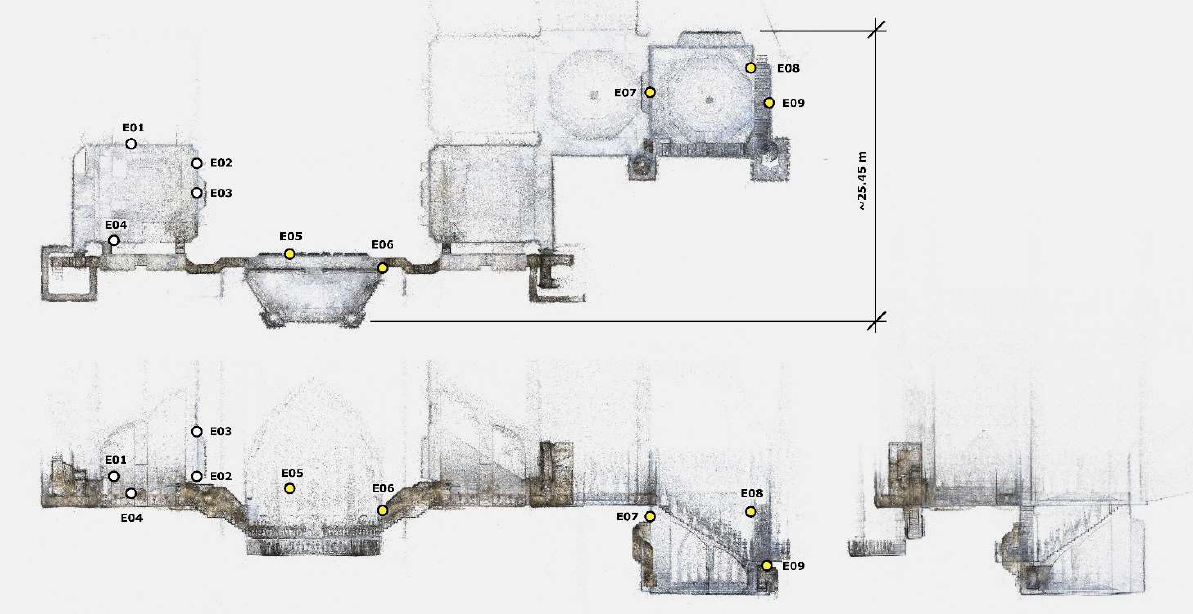
Figure 9. Point cloud result of Path E. Top view (top) and elevation views (bottom): front elevation bottom left and side elevation bottom right. According to Table 3 “Path E”, points in white are used as GCPs in the “max drift check”.